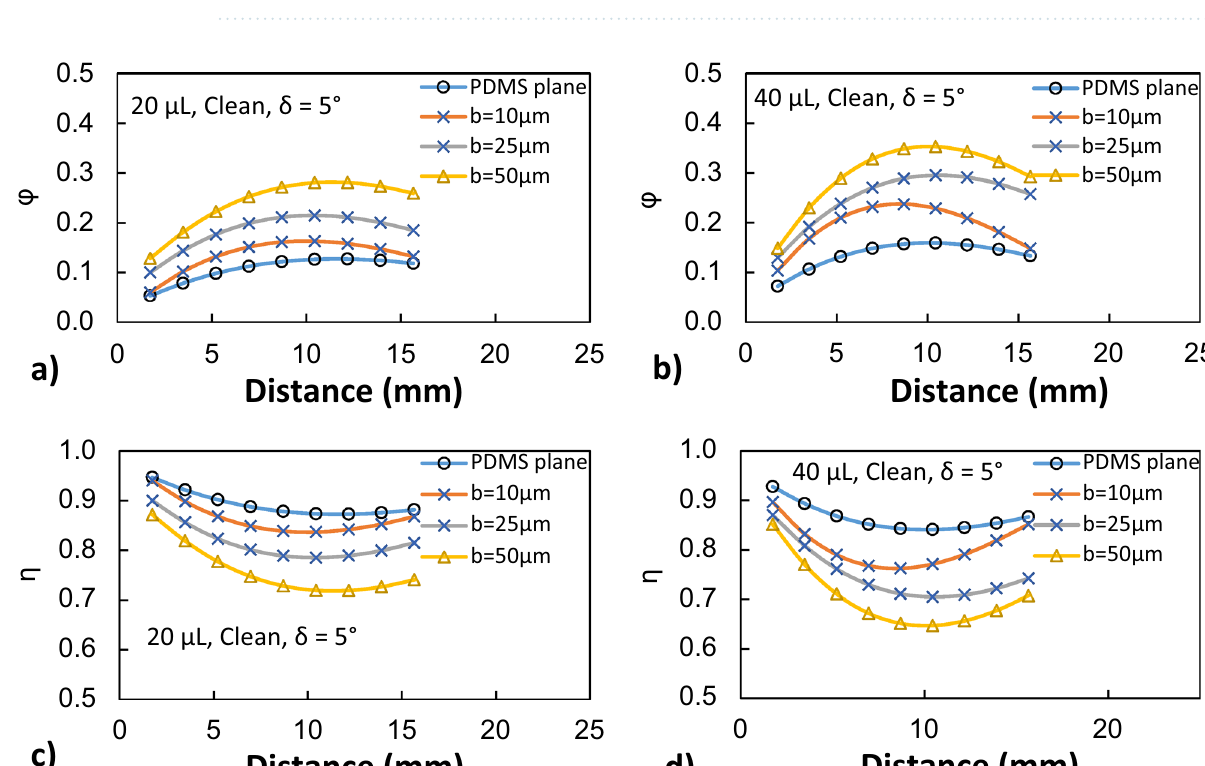
Figure 8. ( a ) Droplet kinetic energy change ratio ( ϕ ) and ( b ) droplet kinetic energy dissipation ratio ( η ) for various micro-post gap